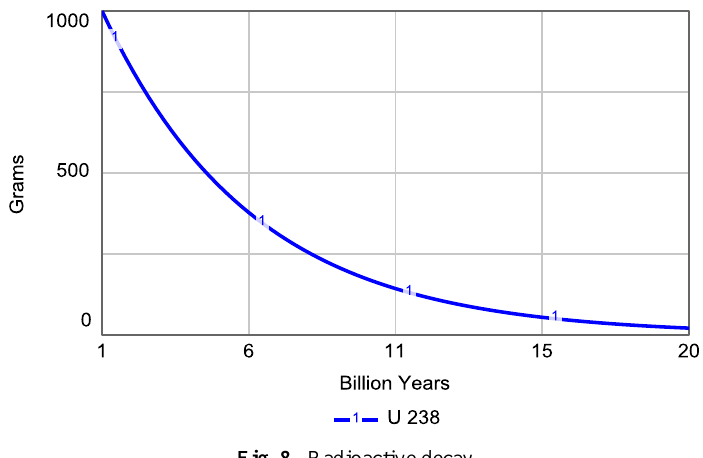
Fig. 8. Radioactive